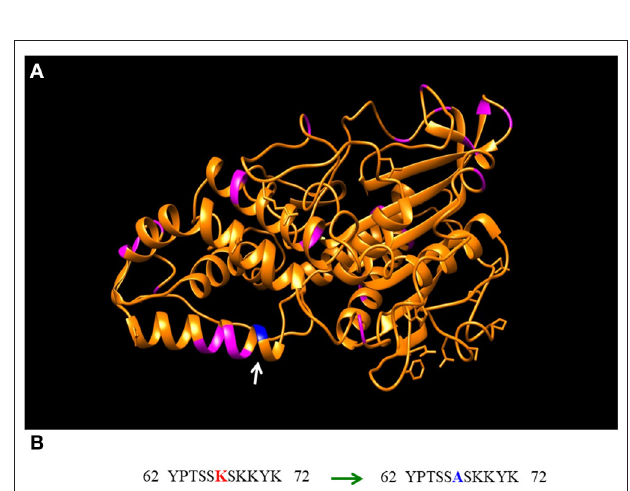
FIGURE 2 | Amino acids sequence (442 residues) and the three-dimensional structure of Aspergillus Fumigatus phytase (accession #1QWO_A) identified an important lysine residue (dark blue) in comparison to all other available lysines (magenta) (A) . Mutation of this residue (lysine “K” 68 to alanine “A”) (B) , leads to a noticeable decrease of pH optima by at least 0.5 to 1.0